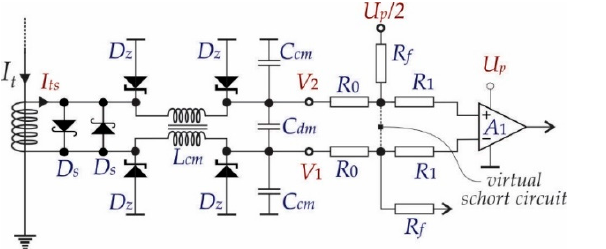
Figure 8. Protection and Common Mode (CM) and Differential Mode (DM) noise reduction